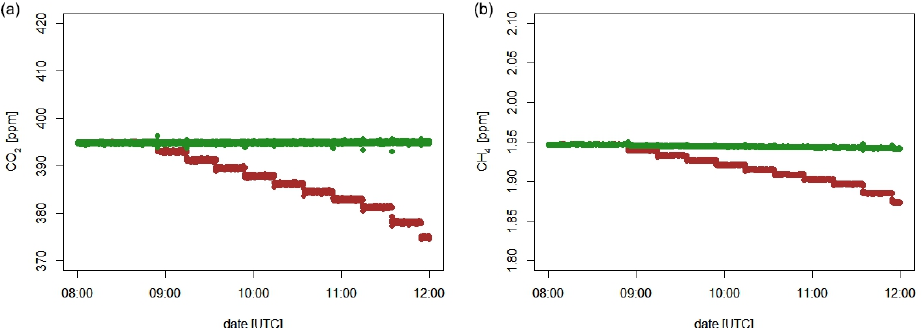
Figure A2. Dry (manufactured correction) and wet values of CO 2 and CH 4 . Green: dry values; red: wet values. (a) CO 2 mixing ratio, (b) CH 4 mixing ratio.